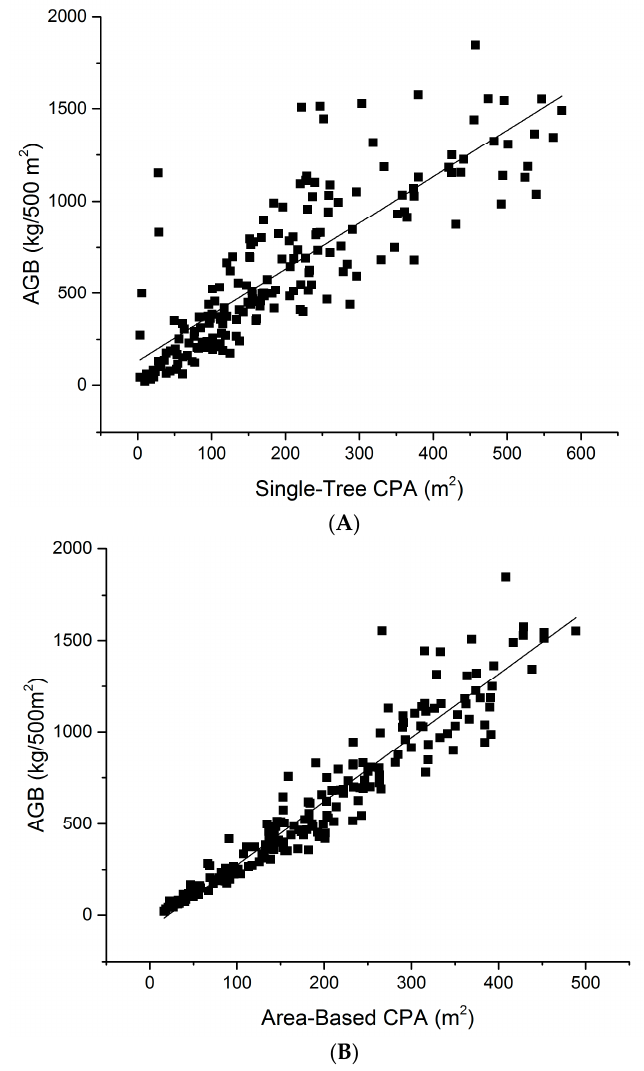
Figure 4. The generalized linear model (GLM) used to predict above ground biomass (AGB) on the basis of crown projection area (CPA) from the single-tree ( A ) and the area-based approach ( B ). Table 2. The parameters and performances of the GLM used to predict the AGB on the basis of CPA from the single-tree and area-based approach. Single-Tree Area-Based